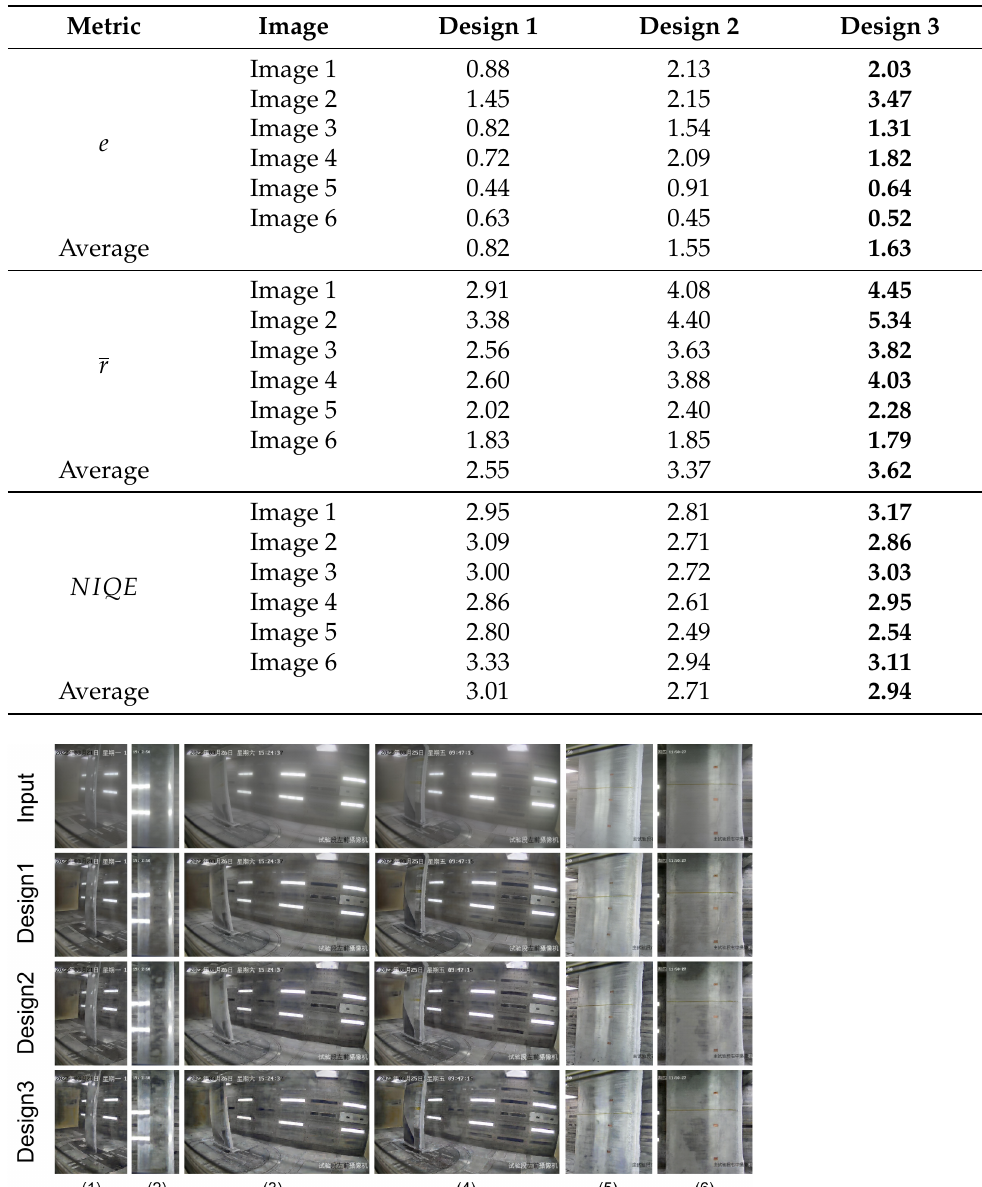
Table 4. Ablation experiment results for modules.